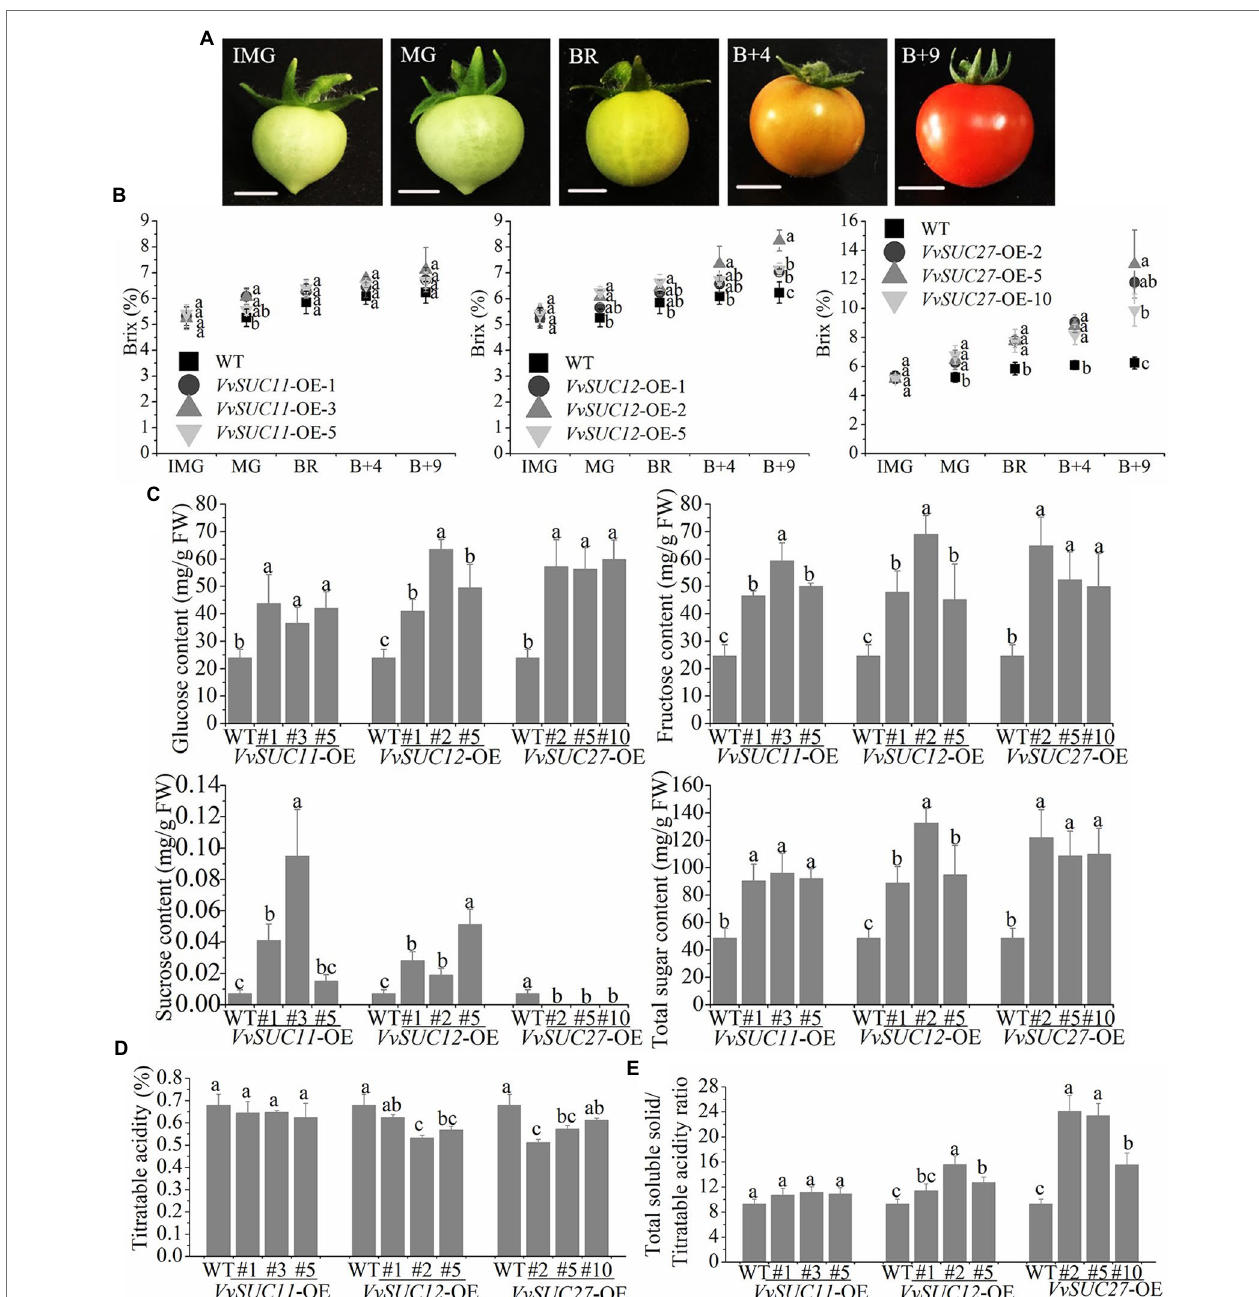
FIGURE 4 | Sugar concentration of the VvSUC -OE tomato fruit. (A) Fruit development in tomatoes. IM, immature; MG, mature green; BR, breaker; B + 4: 4 d after fruit color break; B + 9: 9 d after fruit color break. Scale bar, 50 mm. (B) Comparison between the WT and each VvSUC -OE line regarding different tomato growth phases of soluble solid content. (C) Comparison between the WT and each VvSUC -OE line regarding glucose, fructose, and total sugar concentrations in tomato fruits at the red ripe stage. FW, Fresh weight. (D) Comparison between the WT and each VvSUC -OE line regarding titratable acidity. (E) Comparison between the WT and each VvSUC -OE line regarding the total soluble solid/titratable acidity ratio. Error bars indicate the mean ± SD of nine biological replicates. Different lowercase letters show statistically significant differences between the WT and each VvSUC -OE line (Tukey’s test, p <